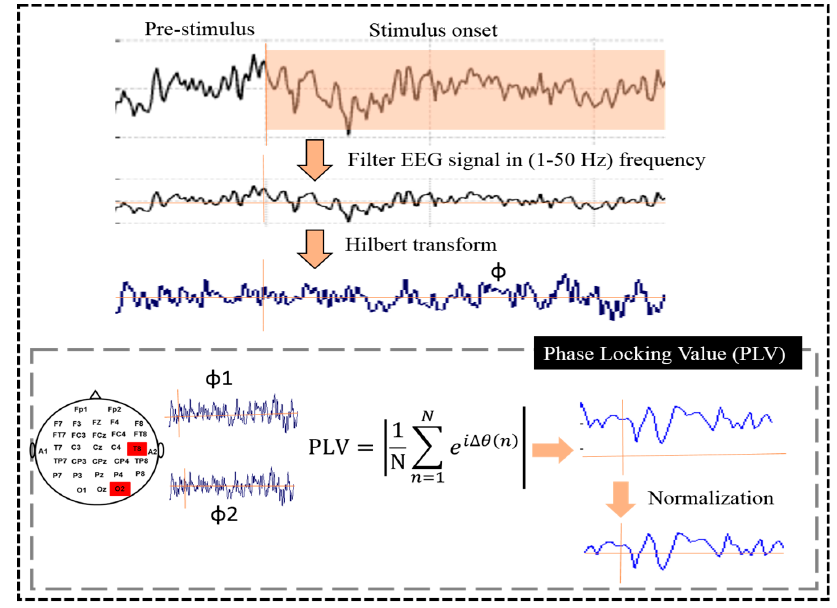
Figure 3. The flowchart of the proposed phase-locking value (PLV) method.